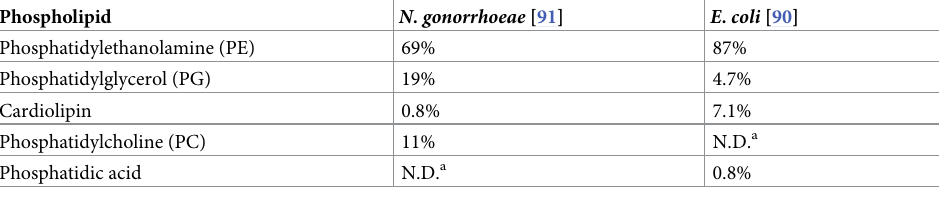
Table 4. Phospholipid composition of N . gonorrhoeae and E . coli